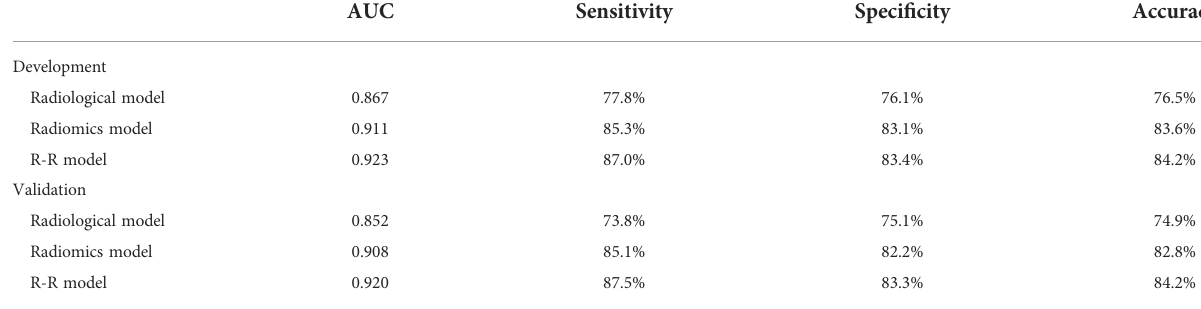
TABLE 3 Predictive performance of Radiological, Radiomics and R-R model.